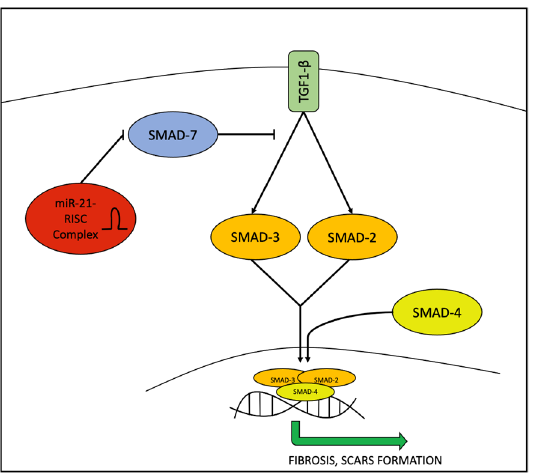
Figure 2. The role of miR-21 in regulating the TGF1- β /SMAD2/3SMAD4 pathway. miR-21 negatively regulates SMAD7, which acts as an inhibitor, leading to the final result of promoting fibrosis process.